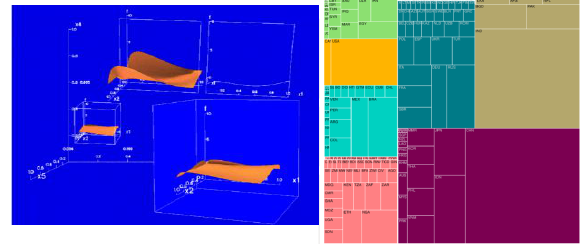
Figure 6. World-within-worlds (left) (Beshers and Feiner, 1993) and Treemap (right) (URL-2)